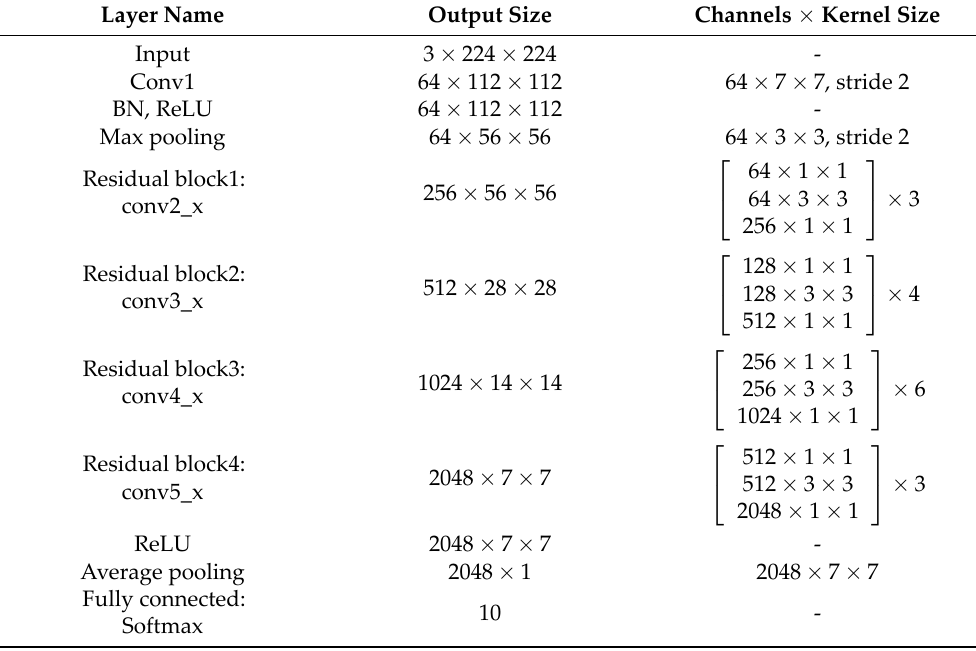
Table 1. Resnet‑50 structure information